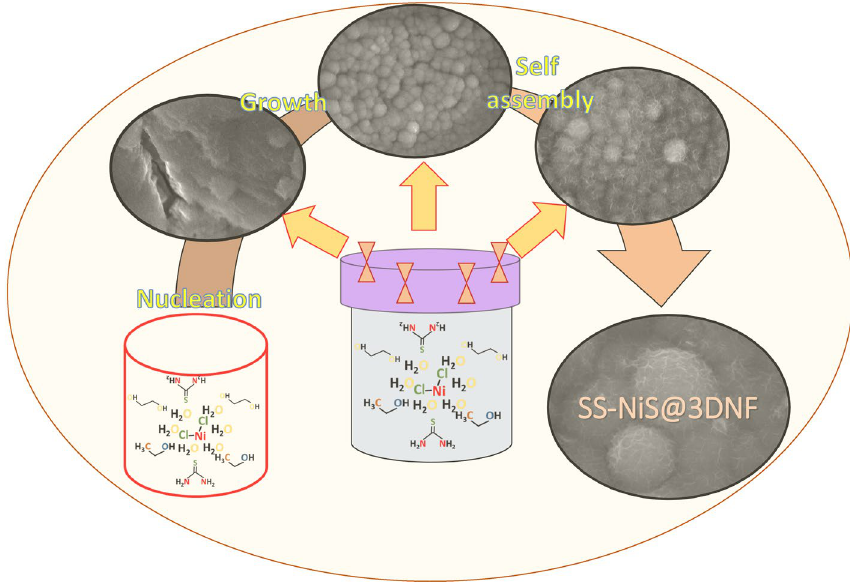
Figure 3. Schematic presentation of the SS-NiS@3DNF electrode